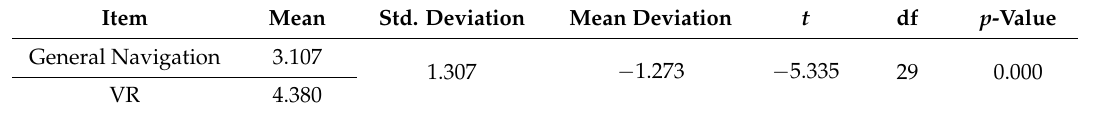
Table 3. Hypothesis test of perceived usefulness.